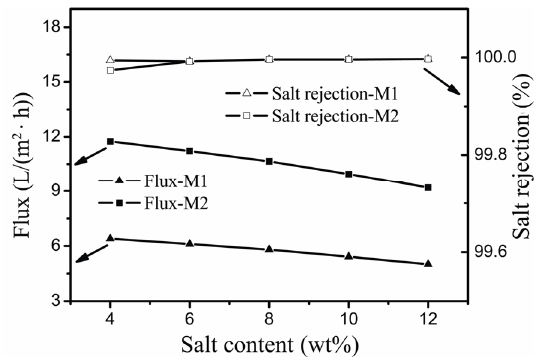
Fig. 8 Water flux of M1 and M2 as a function of the feed NaCl